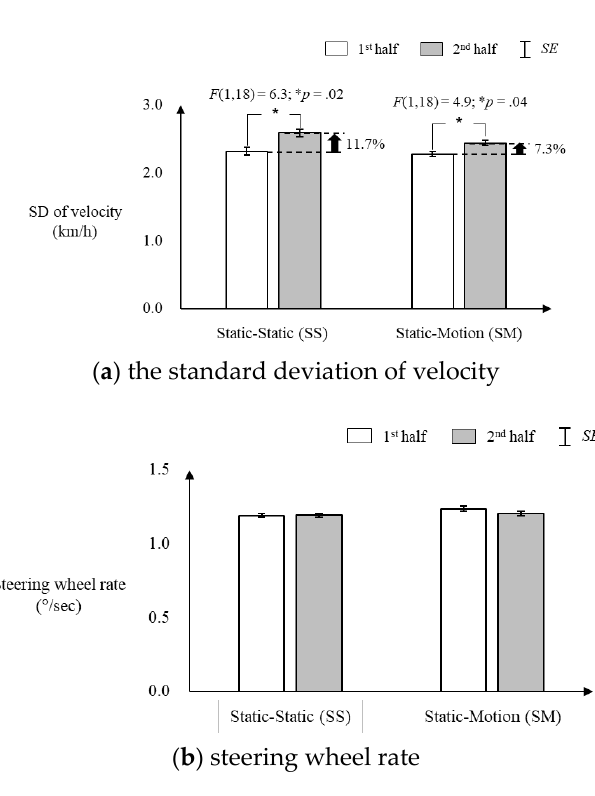
Figure 4. Changes in driving performance between the first-half and second-half driving sessions for the static (S) and motion (M) seat conditions.